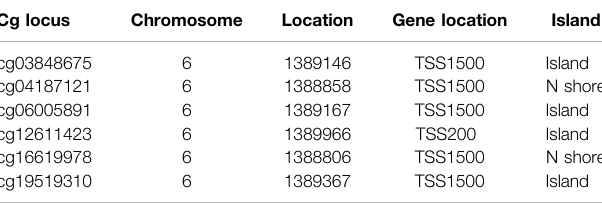
TABLE 1 | Information on the 6 cg loci in the FOXF2 promoter